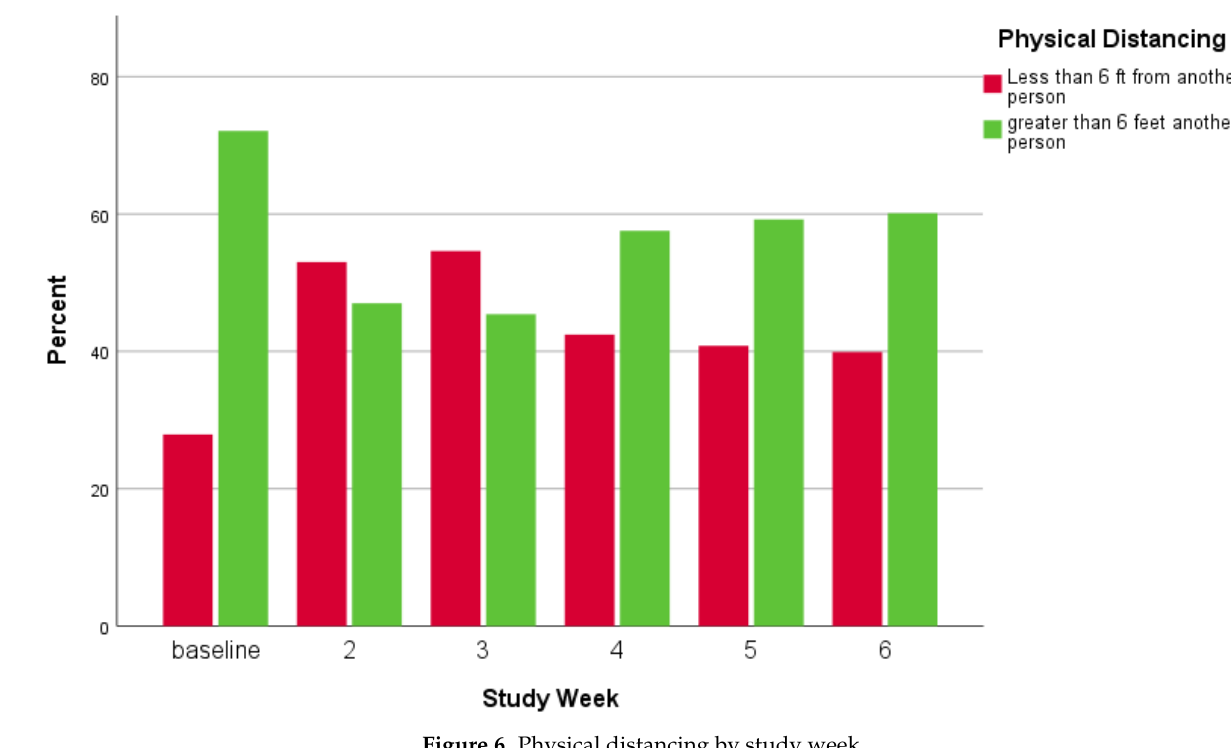
Figure 6. Physical distancing by study week.